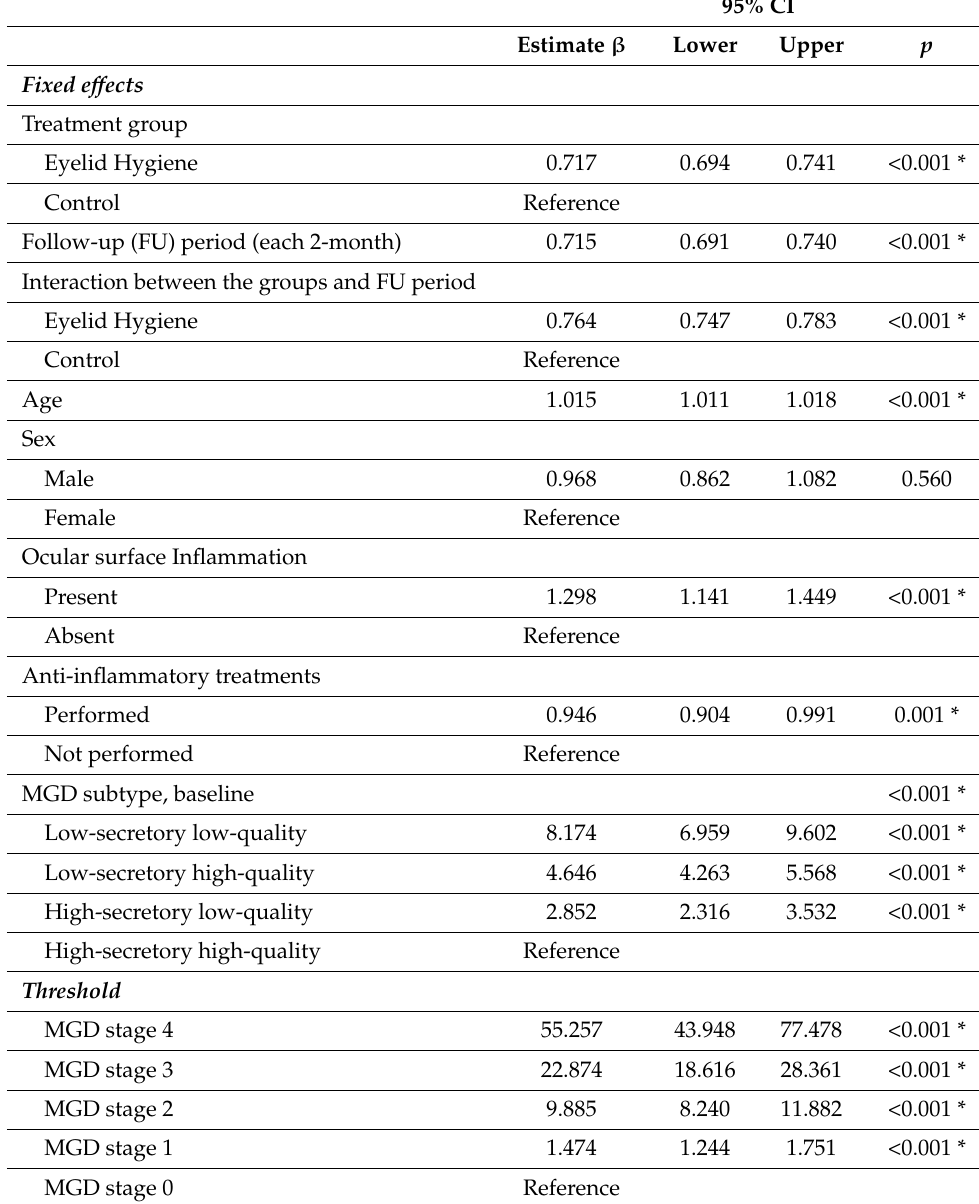
Table 2. Influence of eyelid hygiene on the meibomian gland dysfunction